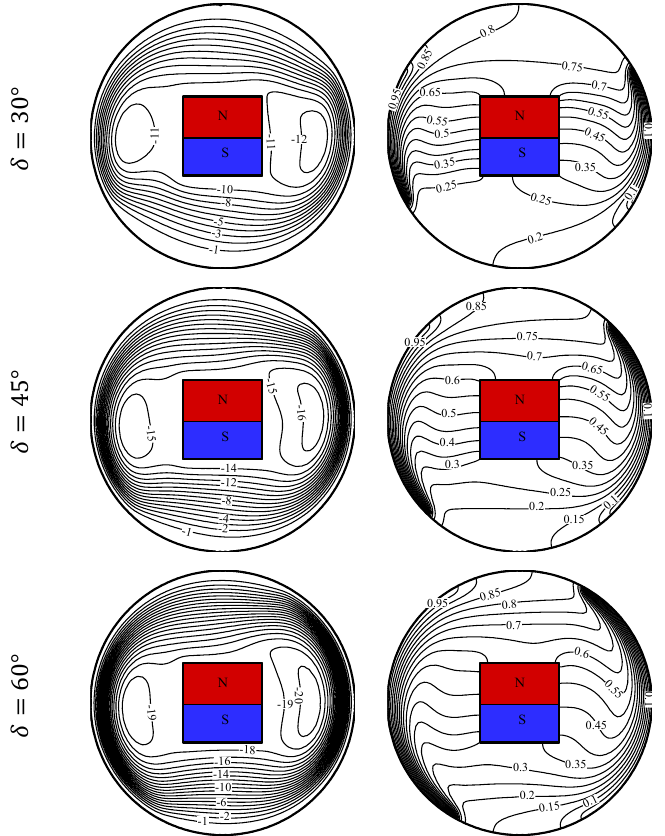
Figure 12. dependence of the streamline and isotherms on the arc size of the hot and cold Figure 12. Dependence of the streamline and isotherms on the arc size of the hot and cold walls when = 10 (cid:2875) , Ra = 10 (cid:2874) 𝑛 = 1.0 , 𝜆 = 0 , Pr = 100 , Ma = 10 (cid:2879)(cid:2872) and 𝛽 walls when Ra Ra M = 10 7 , Ra T = 10 6 n = 1.0, λ = 0, Pr = 100, Ma = 10 − 4 and β c = T M